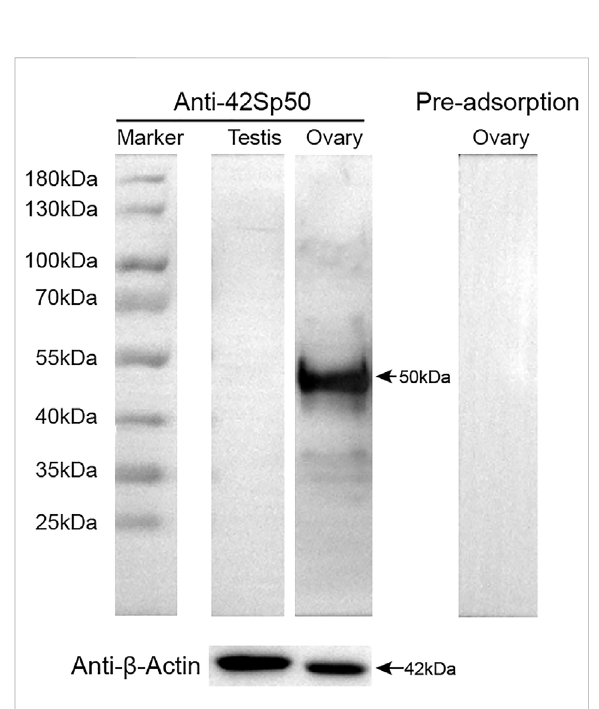
Speci fi city of anti-42Sp50 antibody analyzed by Western blotting. β -Actin abundance was examined as the loading control. The primary antibody which was preadsorbed with its respective recombination protein was used as negative